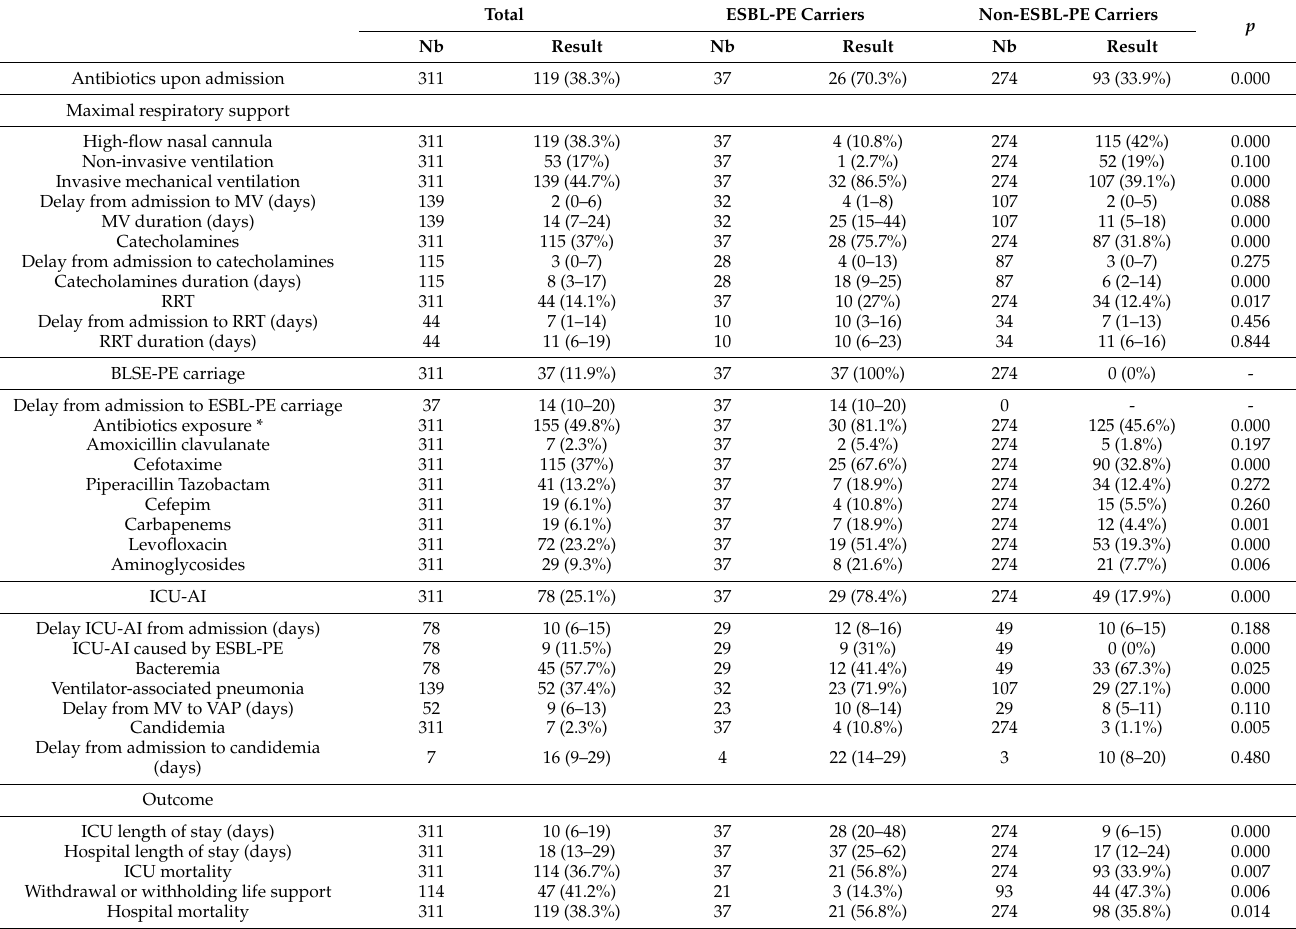
Table 3. Management and